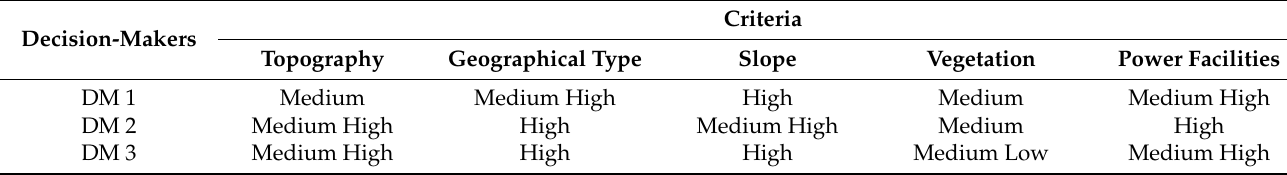
Table 7. The linguistic values of each criterion.